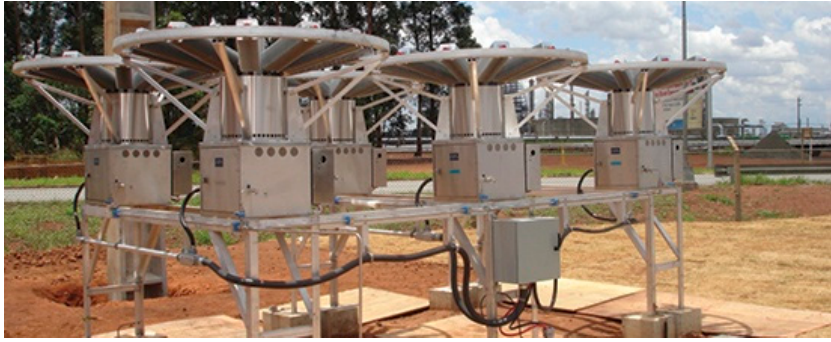
Figure 8. Gentherm Gas TEG [119].